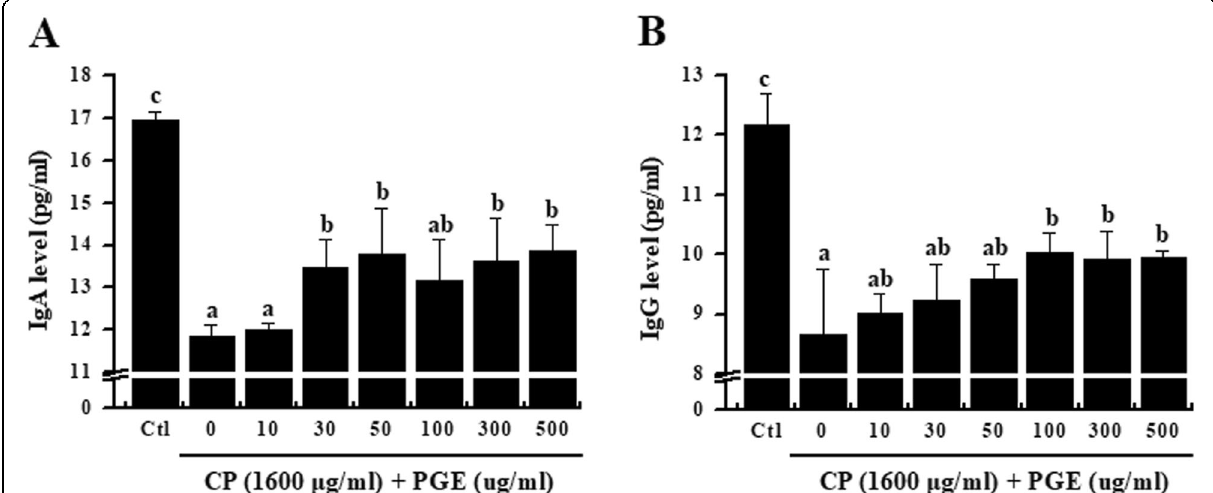
Fig. 4 Effect of PGE on immunoglobulin levels in CP-treated splenocytes. Cells were seeded into 96-well plates, followed by treatment with PGE (0, 10, 30, 50, 100, 300, and 500 μ g/mL) and/or CP (1600 μ g/mL) and incubated for 24 h in a 5% CO2 incubator. Levels of IgG ( a ) and IgA ( b ) secretion into the culture medium were analyzed using ELISA kits. Bars labeled with different superscripts have significantly different values ( P < 0.05). Data are presented as the means ± standard errors ( n =